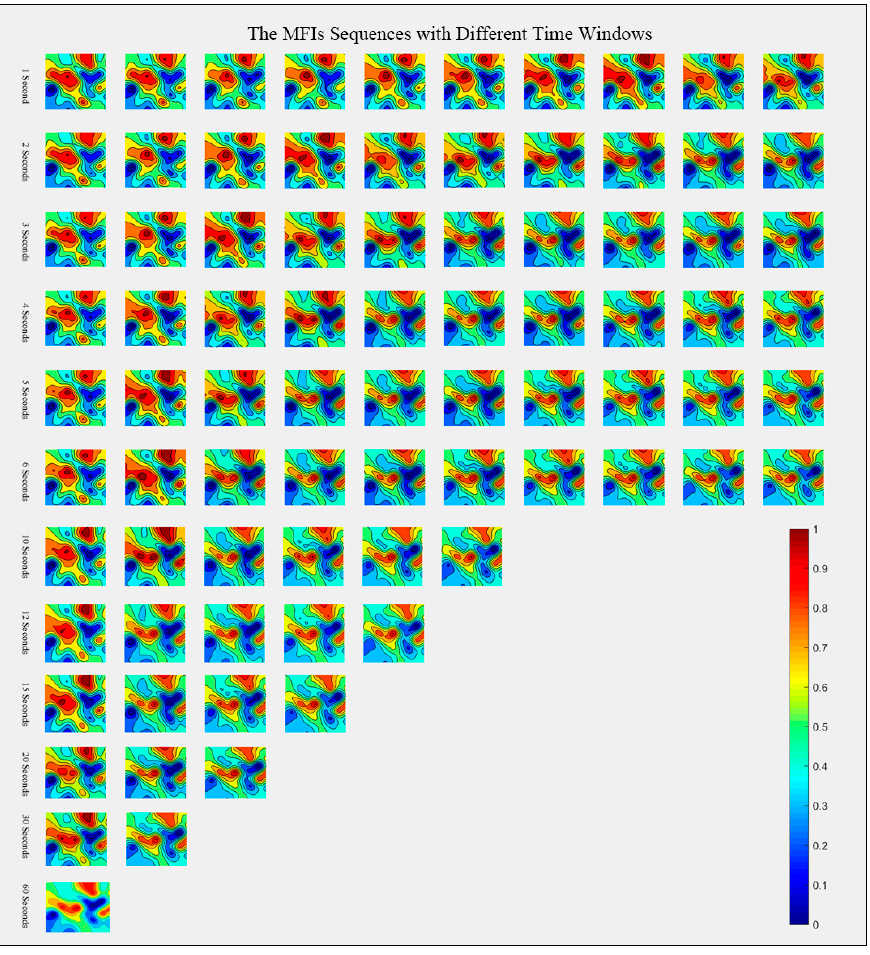
Figure 10. MFI sequences with different time windows corresponding to Subject 4 (corresponding to the emotion